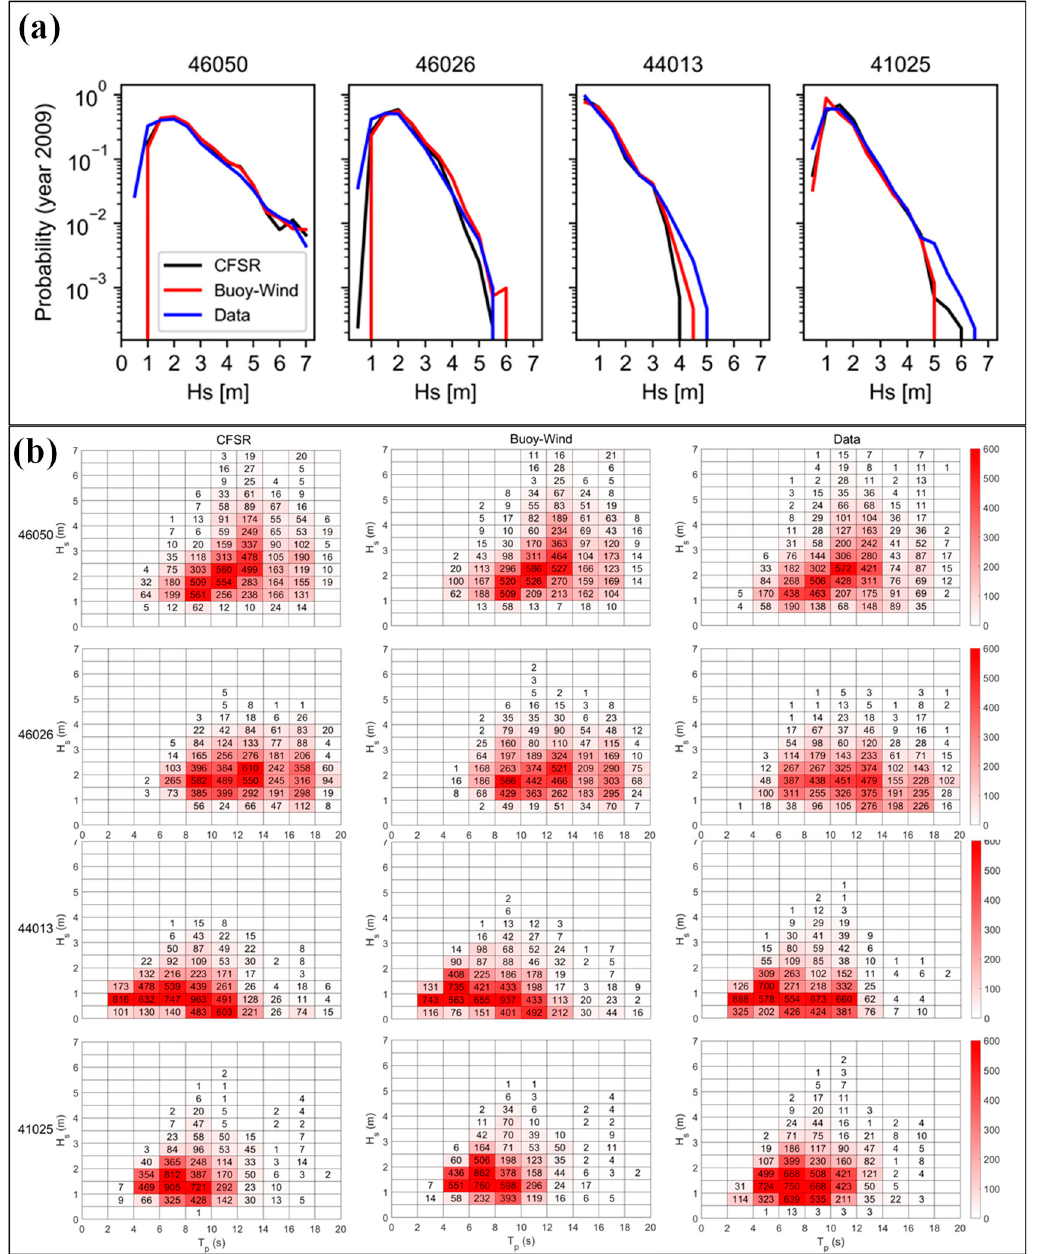
Figure 6. ( a ) Probability distributions of significant wave heights and ( b ) bivariate distribution of occurrence defined by the significant wave height and peak period for the baseline condition, observed-wind condition, and buoy observations in 2009.